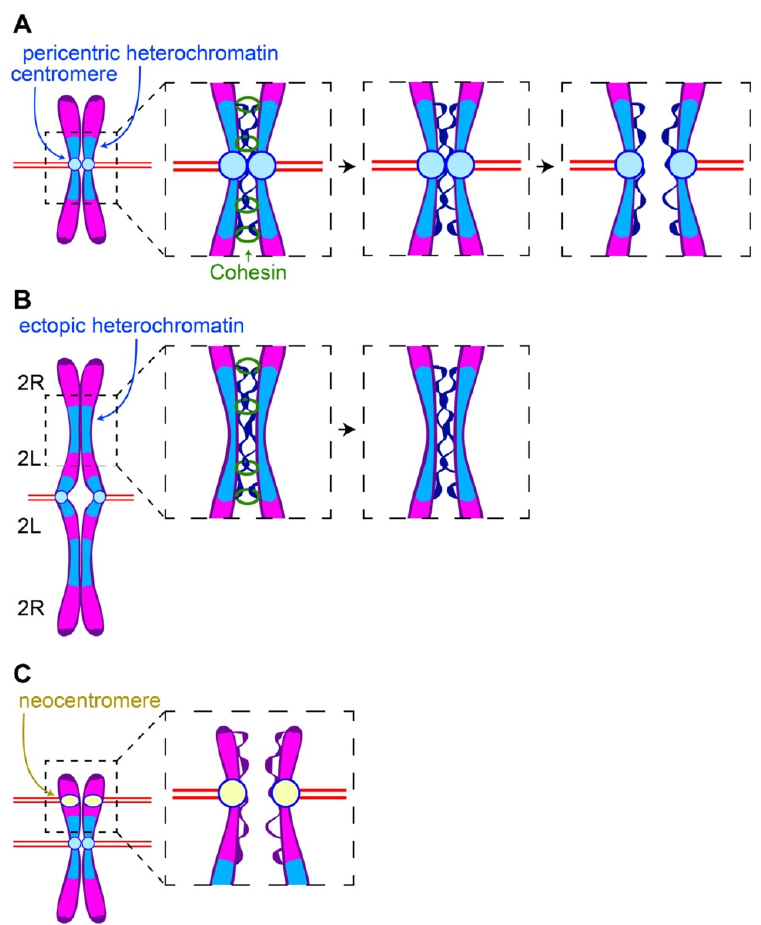
Figure 1. Pericentric heterochromatin and centromeres balance binding and pulling forces on the sister chromatids. ( A ) Once Cohesin is removed, sister chromatids remain bound through DNA catenations at the pericentric heterochromatin. Microtubules attached to opposing kinetochores provide the force required for decatenation and separation of sister chromatids. ( B ) The microtubule pulling force is reduced in the regions in which large blocks of heterochromatin are displaced from their centromeres. Consequently, resolution of sister DNA catenations in the displaced heterochromatin is delayed and results in delayed sister chromatin separation in these regions. ( C ) Segregation defects associated with neocentromeres may be due to the fact that they are no longer associated with heterochromatin that would oppose microtubule pulling